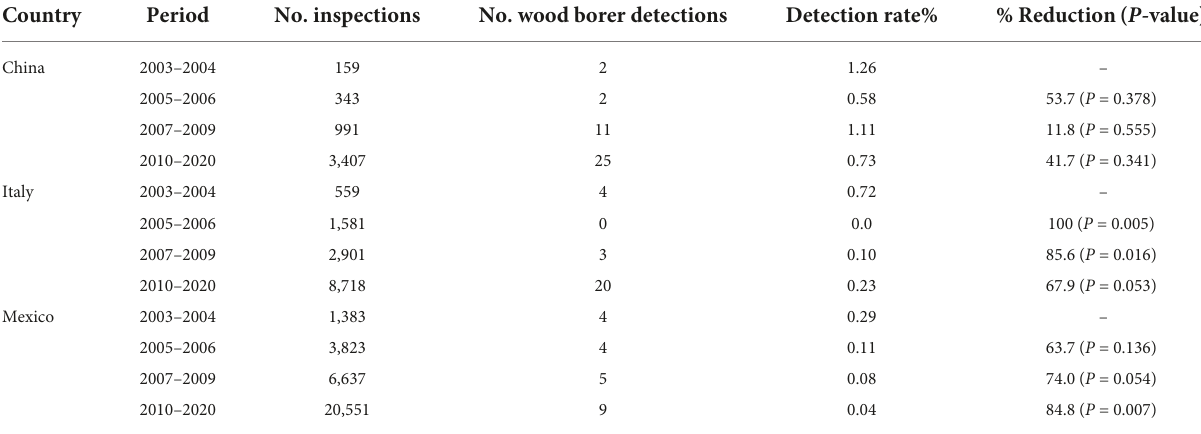
TABLE 5 Detection rates (%) of borer-infested WPM from China, Italy, and Mexico that was inspected as part of the AQIM program during four time periods from 2003 through 2020 that bracket when the US implemented ISPM 15 in 2005–2006. Country